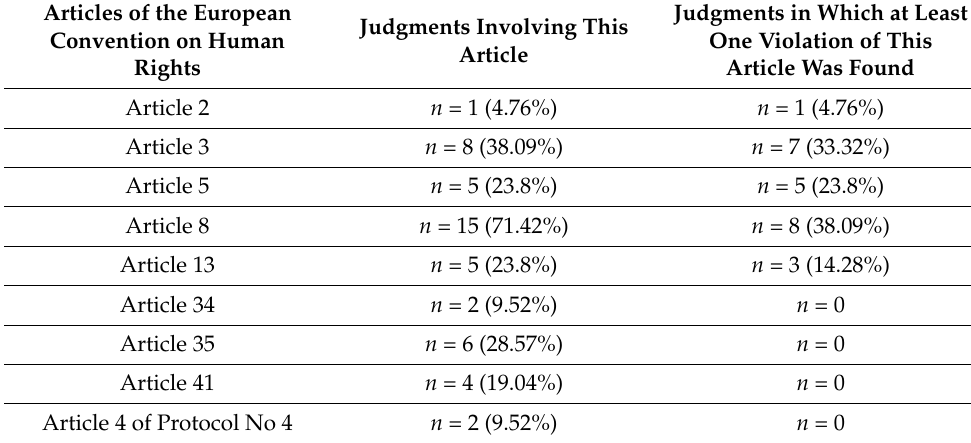
Table 2. Frequencies of Articles of the European Convention on Human Rights involved in the n = 21 judgments under